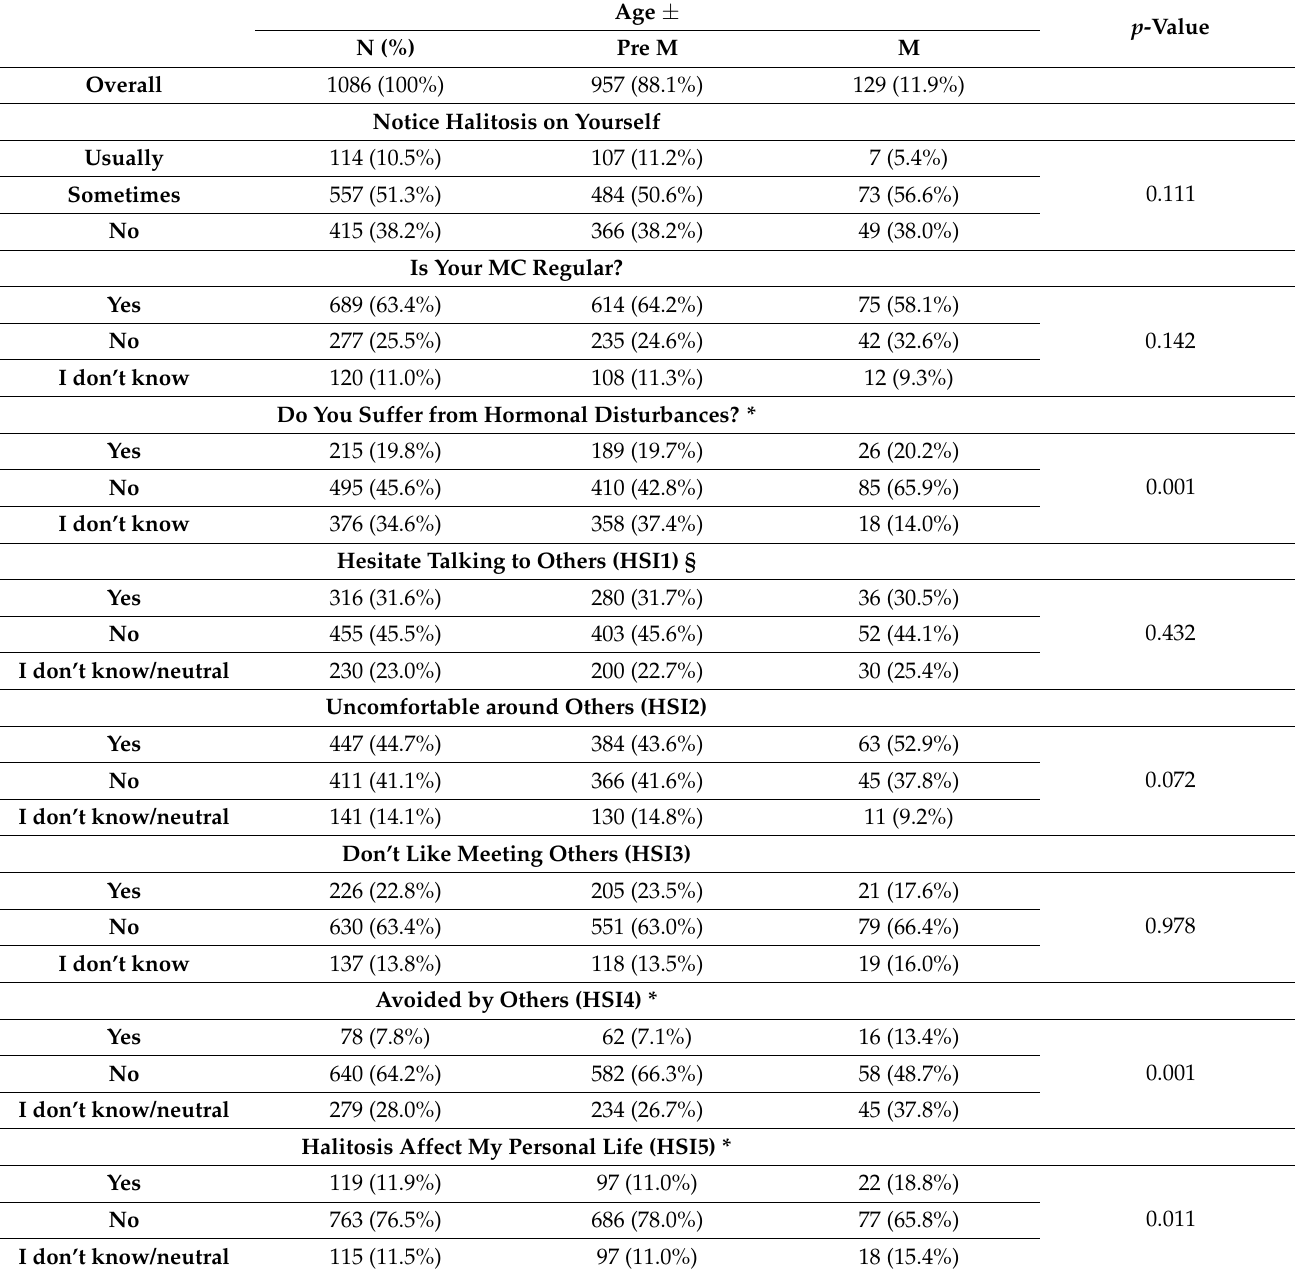
Table 3. Association of several questionnaire domains: (1) halitosis self-perception, (2) regularity of menstrual cycle, (3) reported hormonal disturbances, (4) halitosis social impact, and (5) menstrual cy- cle halitosis perception with dichotomous category of age, namely, pre-menopausal and menopausal (pre = m and m,